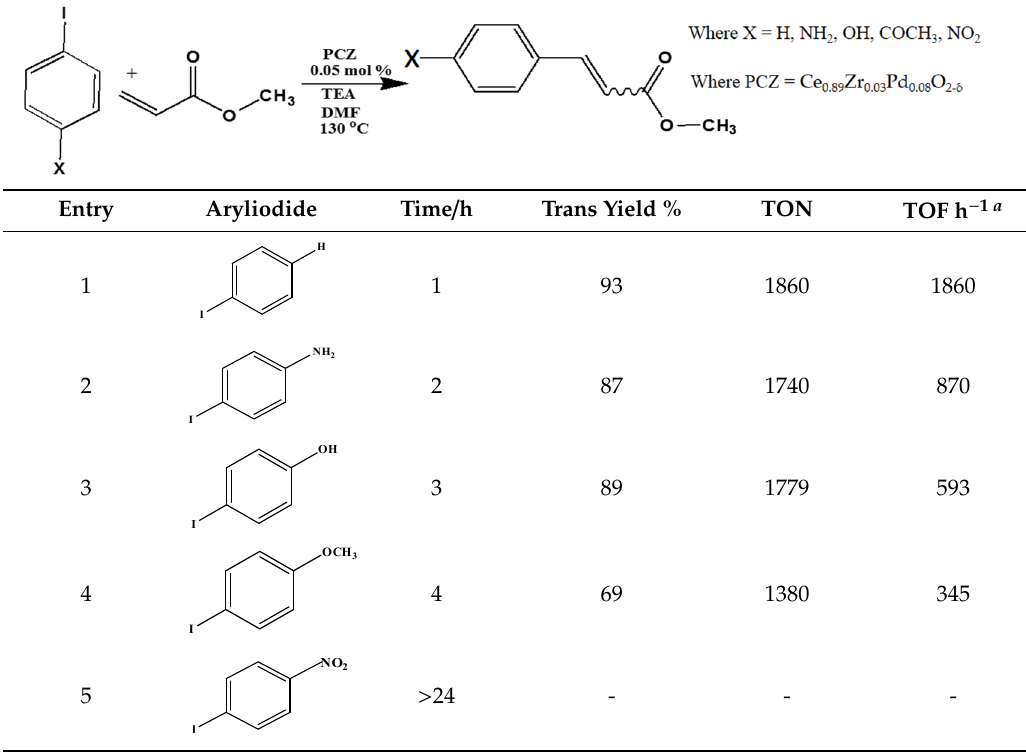
Table 5. Influence of para-substituents on yield and progression of reactions.